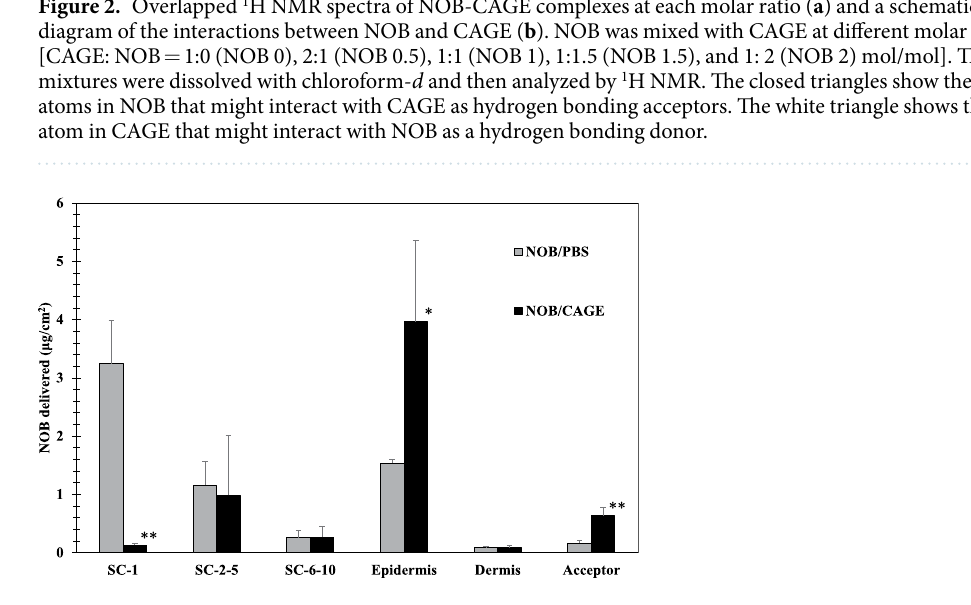
CAGE ( P < 0.01). In contrast, as for NOB/CAGE, the amount of NOB detected in epidermis and acceptor, deep fractions of the skin, was significantly greater than that of NOB/PBS ( P < 0.05 or P < 0.01). These results indi- cated that the NOB from NOB/CAGE samples can cross the SC layer without stagnation, and pass through to the deep sites in the skin; while PBS cannot deliver NOB across the SC and the NOB remained at the skin surface. Therefore, NOB absorption and permeation were found to be improved using CAGE.